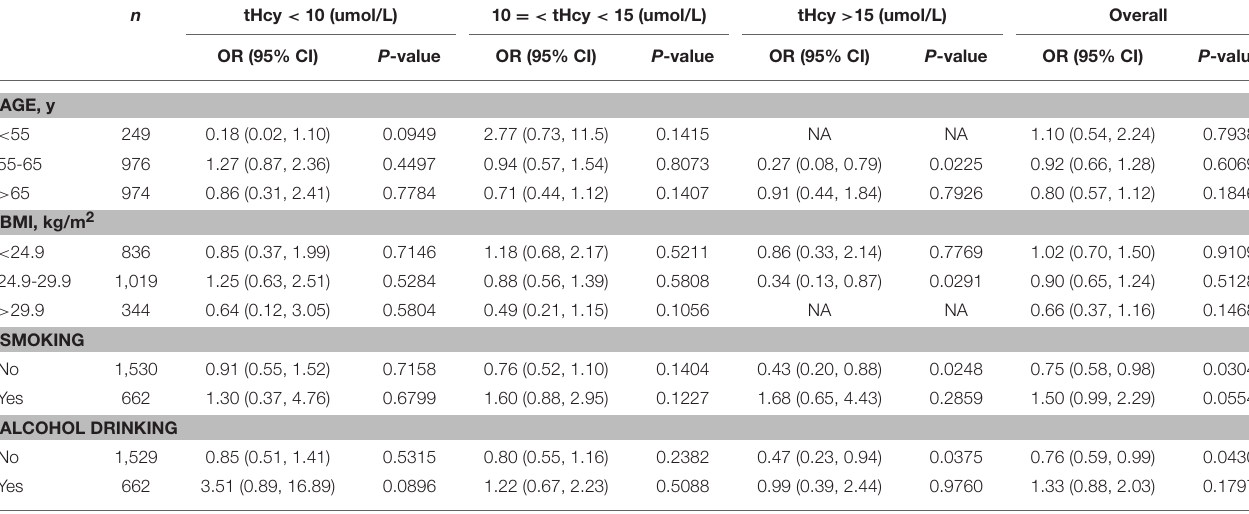
TABLE 5 | Logistic regression analysis of folic acid supplementation in relation to RA in different